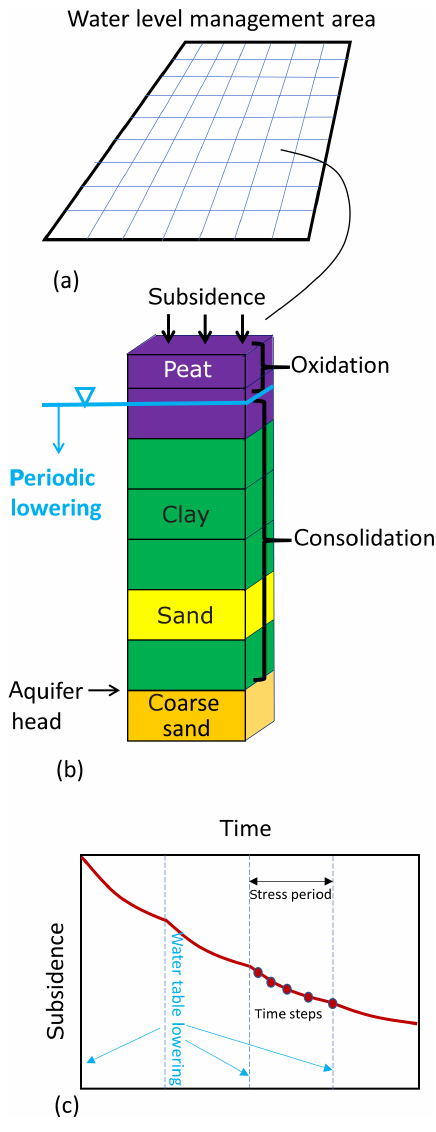
Figure 2. Different component of discretization. (a) The to- tal model domain is subdivided into cells that are grouped into WLMA’s (generally not rectangular). (b) Schematic representation of a voxel stack for an individual cell. (c) Time discretization in terms of stress periods and time